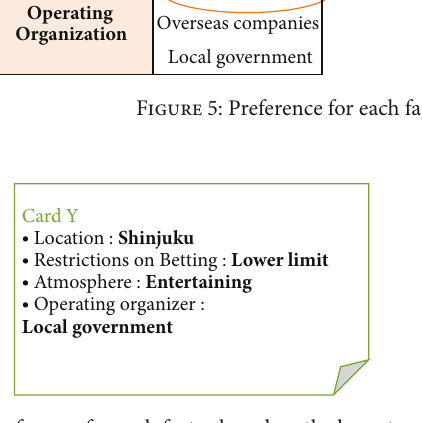
Figure 6: Preference for each factor based on the lowest preference scores (Card